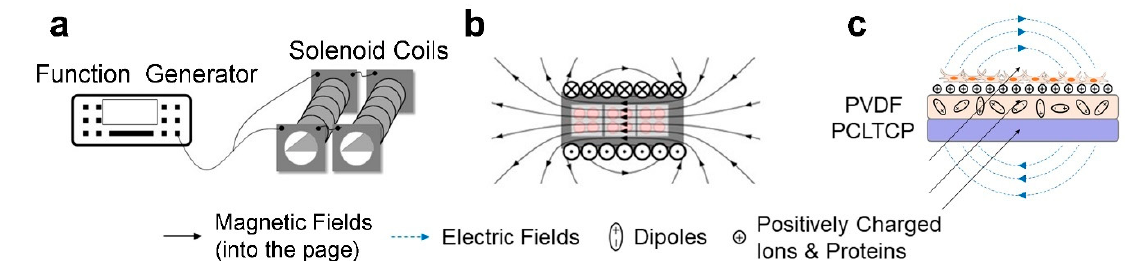
Figure 8. Experimental set-up. ( a ) Equipment set-up. ( b ) Arrangement of cell culture plates in solenoid coils. ( c ) Electric and magnetic fields’ orientation.